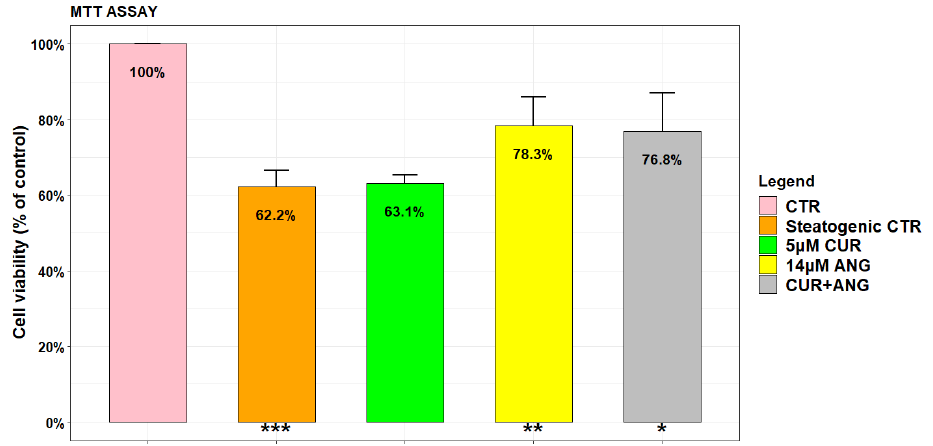
Figure 2. Effects of the steatogenic medium, curcumin, andrographolide, and curcumin + andro- grapholide on the viability of HepG2 cells. After 24 h of exposure to steatogenic medium, the cells were treated for an additional 24 h with 5 µ M curcumin and 14 µ M andrographolide employed alone or in association. Cell viability was assessed by the MTT assay. The results are expressed as the mean ± SD of six independent experiments. Level of significance: *** p < 0.001; ** 0.001 < p < 0.01; * 0.01 < p < 0.05; steatogenic control with respect to the control or treated cells with respect to the steatogenic control.